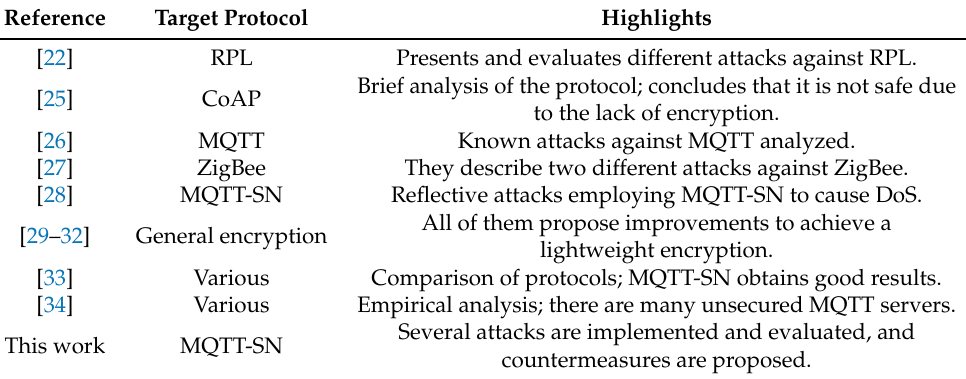
Table 6. Comparison of the state-of-the-art